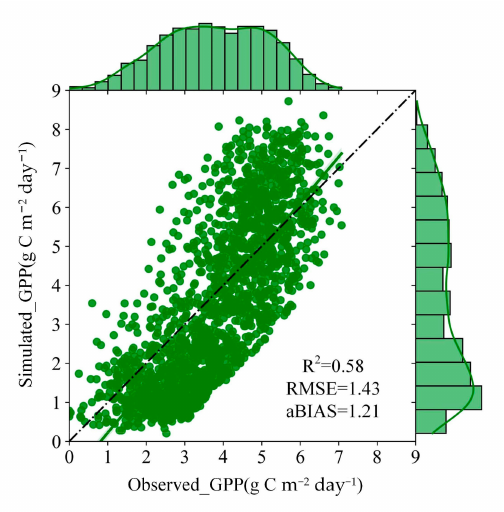
Figure 4. Comparison of the simulated and observed values of GPP.